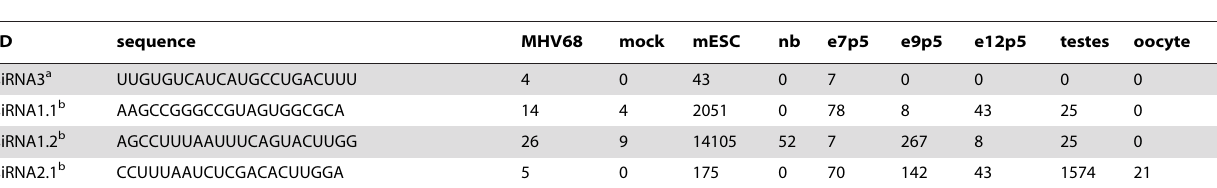
Table 2. Novel and known murine endo-siRNAs represented in 9 sequencing datasets including MHV68-infected (MHV68), mock- treated murine cells (mock; GSE36639); mouse embryonic stem cell (mESC; GSE12521); newborn embryo (nb), 7.5-, 9.5-, and 12.5- day point embryo cells (e7p5 etc.), testes (GSE20384) and oocyte